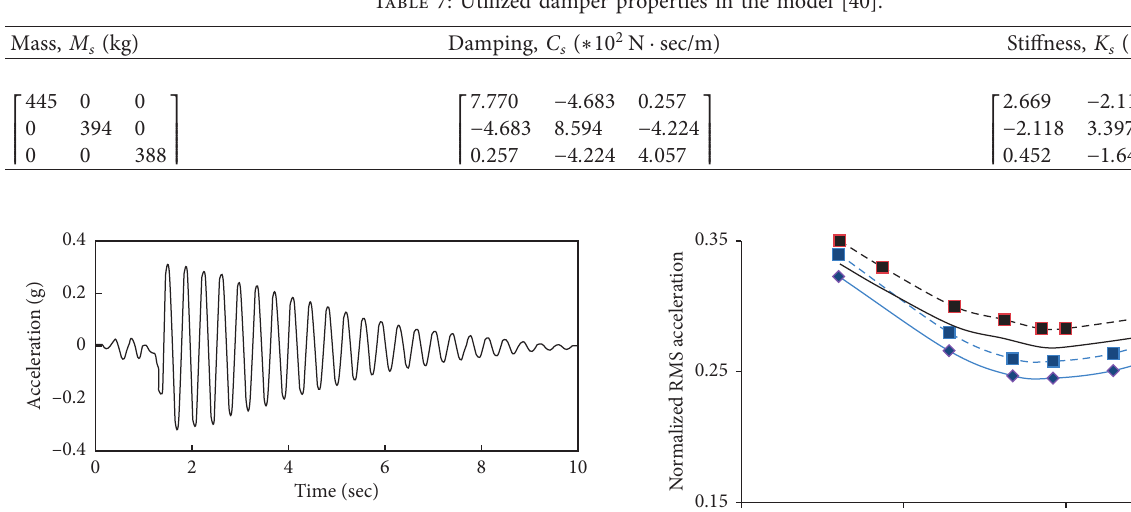
Figure 8: First mode stimulation pattern [40].